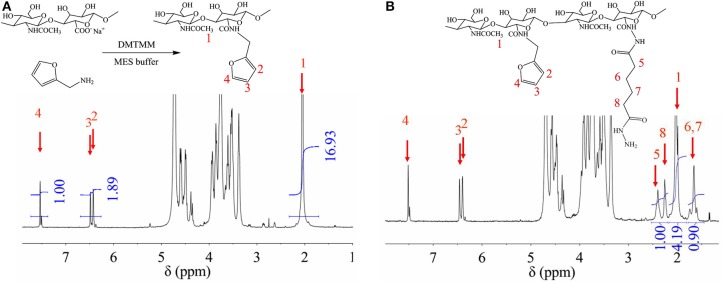
1H NMR of HA-furan (A), and HA-furan-ADH (B).